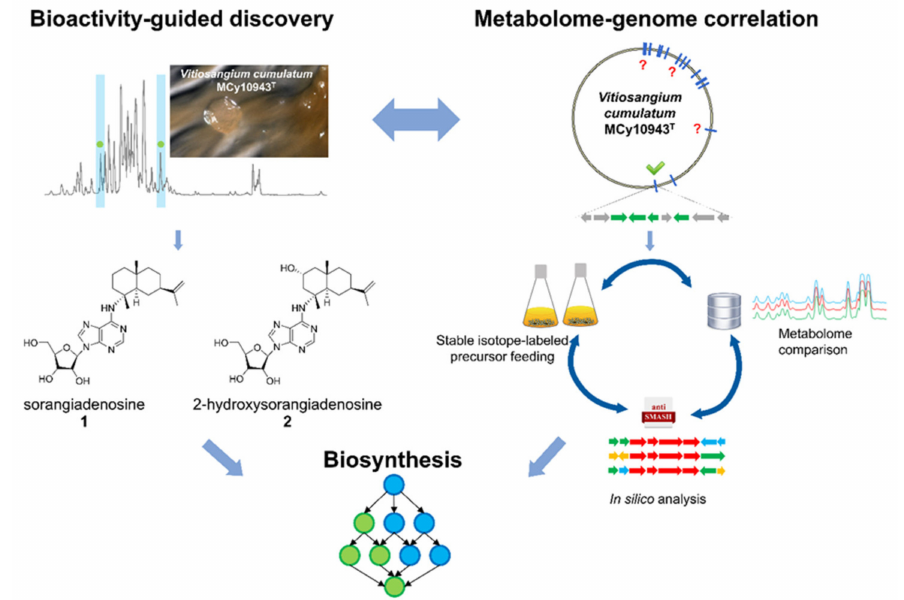
Figure 1. Bioactivity-guided metabolome screening of Vitiosangium cumulatum MCy10943 T led to the re-discoveryofsorangiadenosine( 1 )andthediscoveryof2-hydroxysorangiadenosine( 2 ).